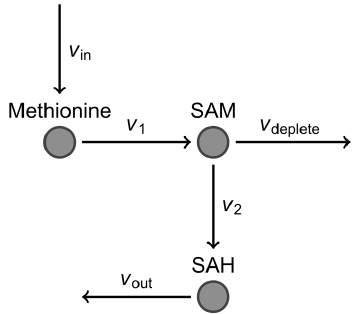
Figure 3. A simplified representation of a subset of reactions in FOCM responsible for DNA